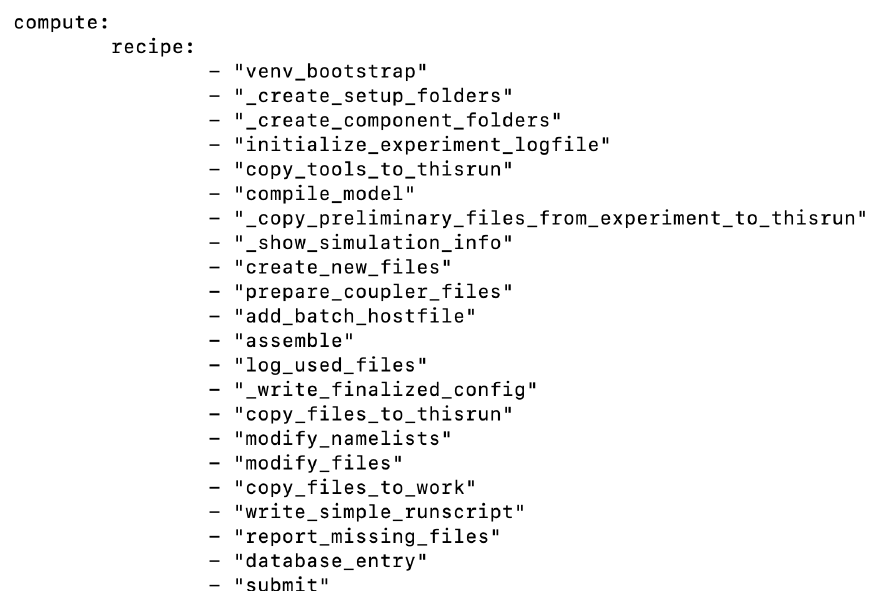
Figure 3. Section of esm_runscripts.yaml defining the order of execution of Python functions in a compute job. The user can easily add new (own)